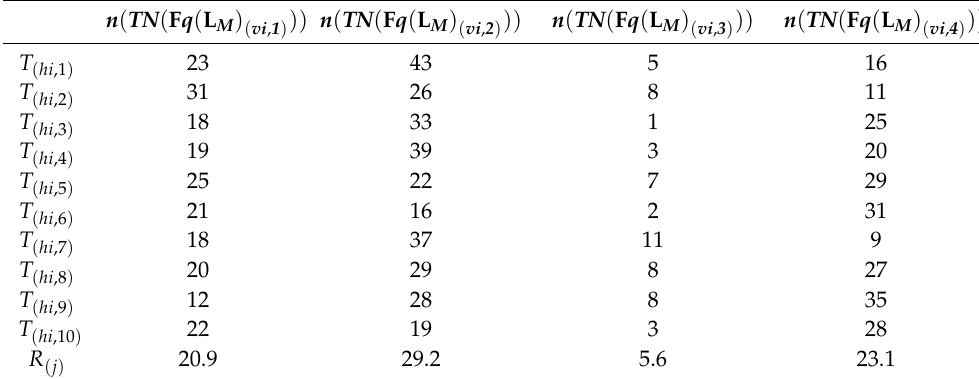
Figure 9. The fluctuating curves of the tourist attraction classification label word frequency and a comparison of the tourist attraction classification recommendation degree. ( a – d ) represent the six column results in Table 5. ( e ) shows the four curves together. ( f ) shows the comparison of ( ) j R .